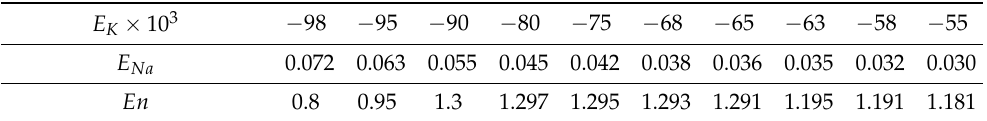
Table 1. Entropy for different parameters.